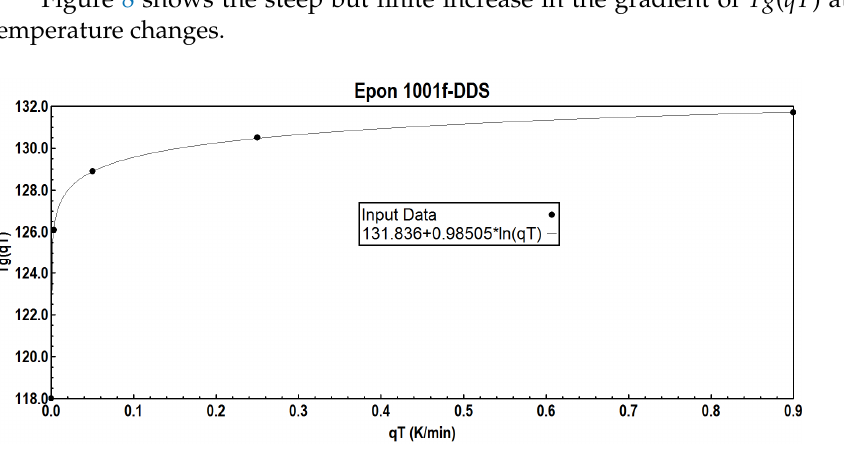
Figure 8. Development of Tg ( qT ) with qT min = 7.95*10 ‐ 7 (r 2 = 0.999 981; σ = 0.028 K; Δ max = 0.032 K).